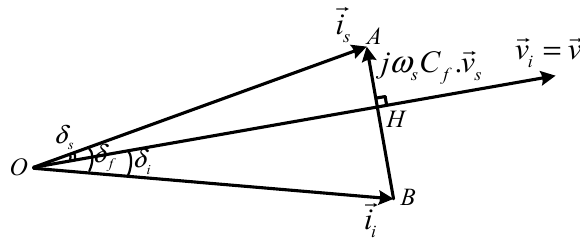
Figure 7. Vector diagram of input voltages and currents with compensated angle δ i